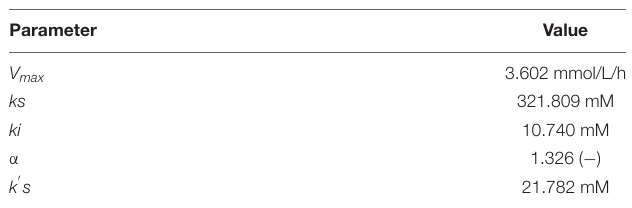
TABLE 2 | Model parameter